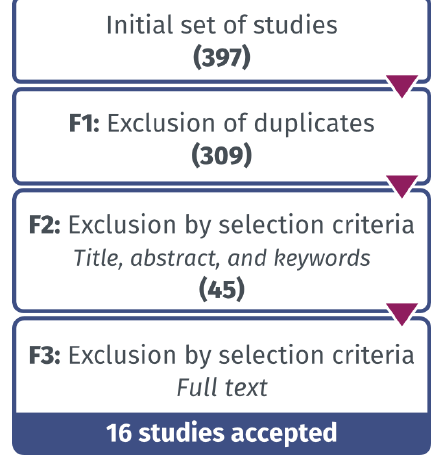
Figure 3. Filtering process followed in the systematic mapping conduction, consisting of three filters: F1, F2 and